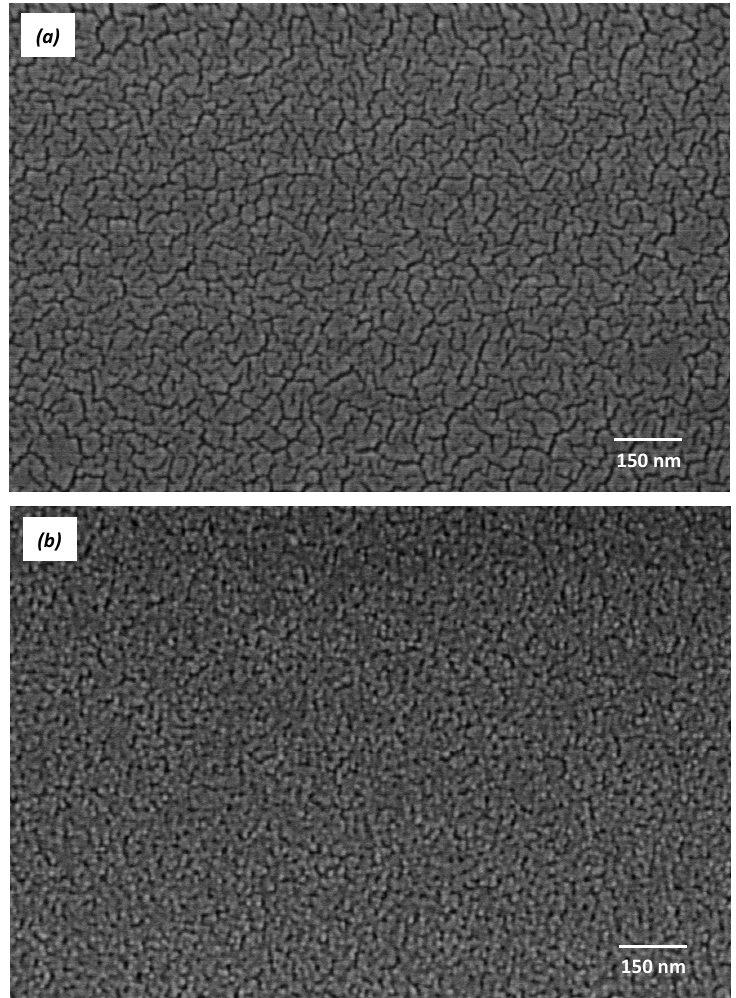
Figure 8. FE-SEM images of ( a ) pure TiO 2 and ( b ) Co-B codoped TiO 2 /ZnO films.